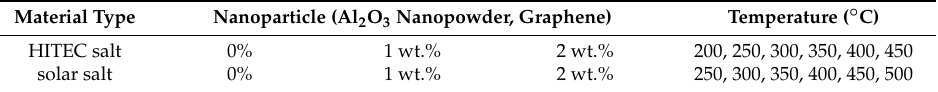
Table 1. Viscosity measurements of salts and nanocomposites in the present study. Material